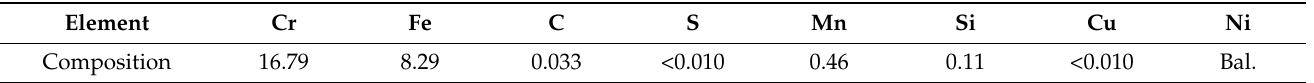
Table 1. Chemical composition of nickel-based alloy 600 (wt.